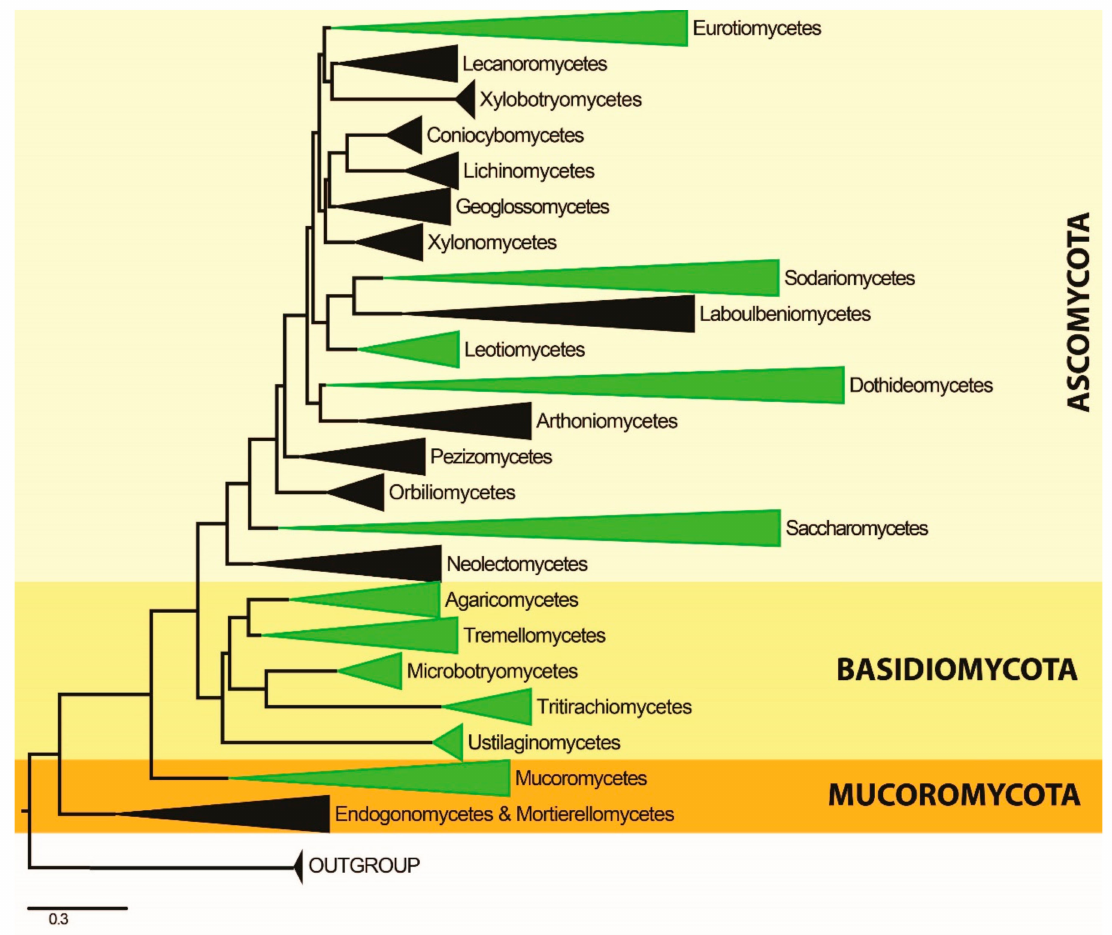
Figure 2. Compressed overview of the phylogram for the phylogenetic relationships of plastic- degrading fungi. Class level taxonomic ranks in Green include fungal species that were reported as plastic